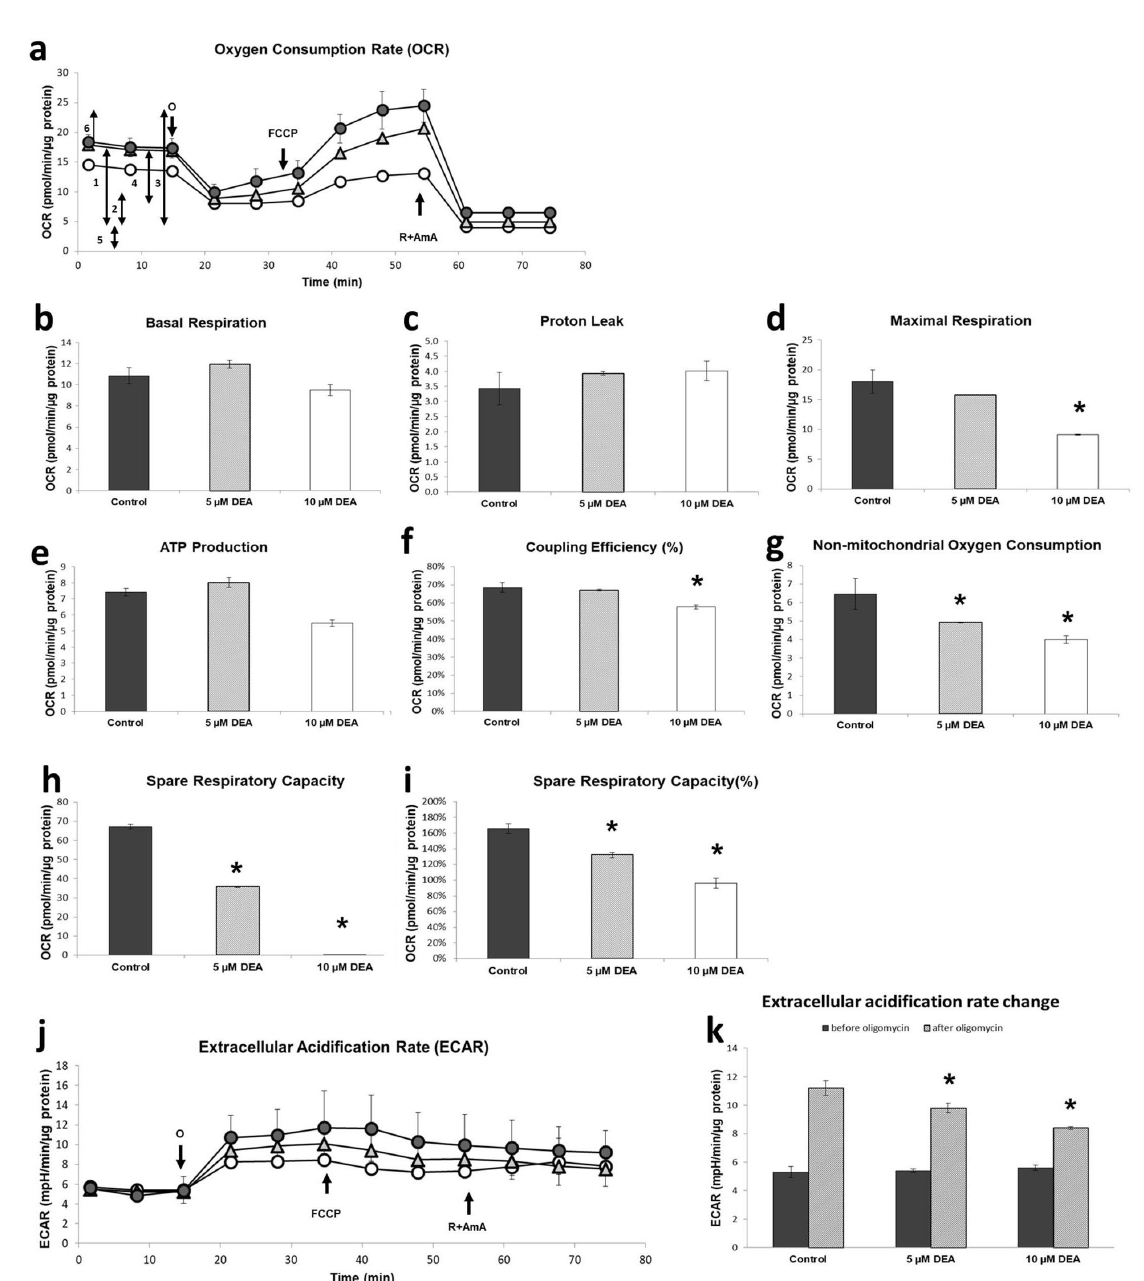
Figure 4. E ff ect of DEA on the energy metabolism of B16F10 melanoma cells. Cells were treated with 5 or 10 µ M of DEA for 3 h, and then the OCR and ECAR were monitored for 75 min. The F o F 1 ATP synthase inhibitor oligomycin (o), the uncoupler FCCP, and the respiratory inhibitors rotenone and antimycin A (R + AmA) were added at the bold arrows. ( a ) OCR recordings for untreated (filled circles), 5 µ M of DEA-treated (triangles), and 10 µ M of DEA-treated (open circles) cells (means ± SD of three independent experiments running in two replicates in each experiment. The double-headed arrows with numbers next to them indicate (1) basal respiration, (2) proton leak, (3) maximal respiration, (4) ATP production, (5) non-mitochondrial oxygen consumption, and (6) spare respiratory capacity. ( b–i ) Parameters derived from ( a ); for explanation, see the text and ( a ). Appropriate parts of the recordings were averaged and presented as the means ± SEM of three independent experiments running in two replicates in each experiment. * indicates a significant di ff erence relative to the control ( p <